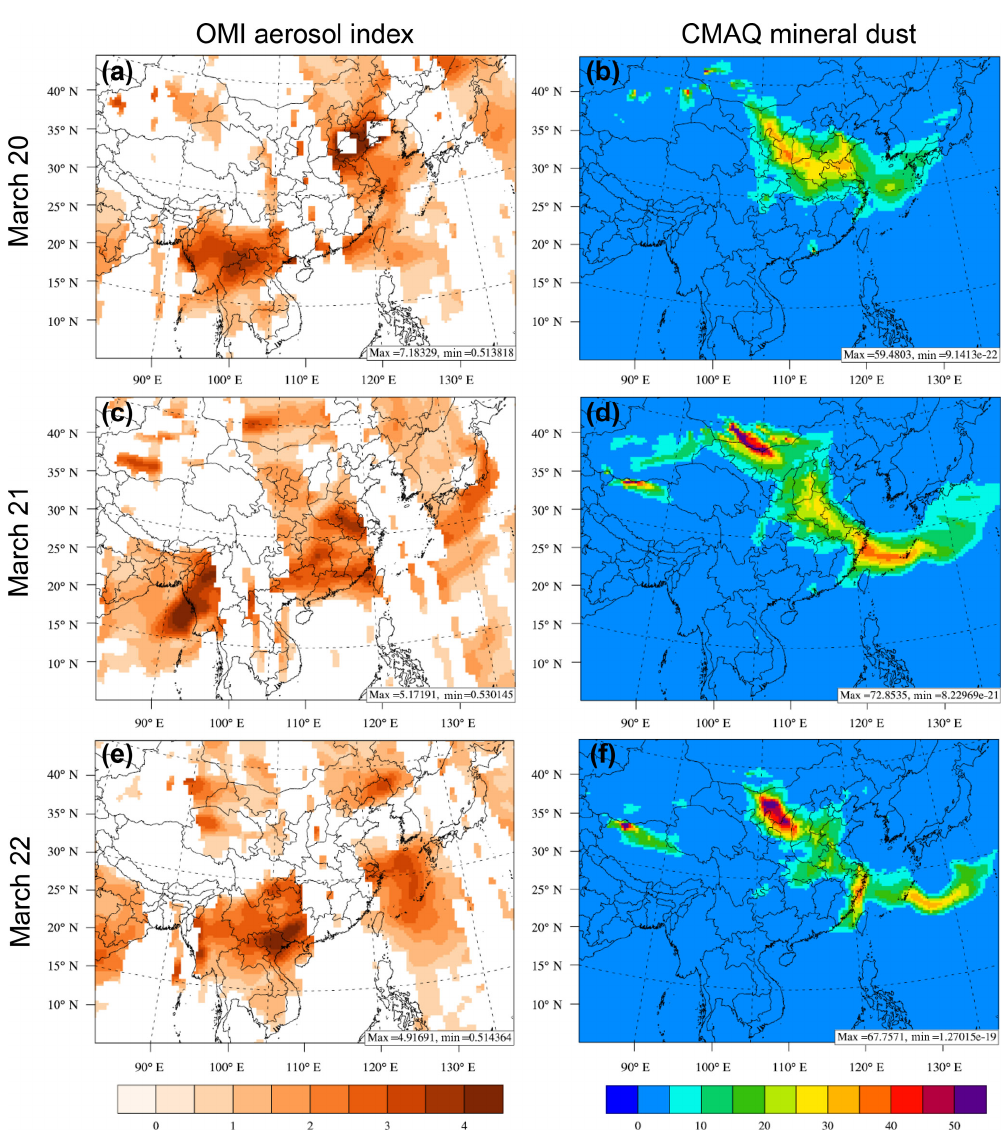
Figure 9. The spatial distribution of OMI ultraviolet aerosol index (unitless) and simulated mineral aerosols (µgm − 3 ) from 20 to 22 March